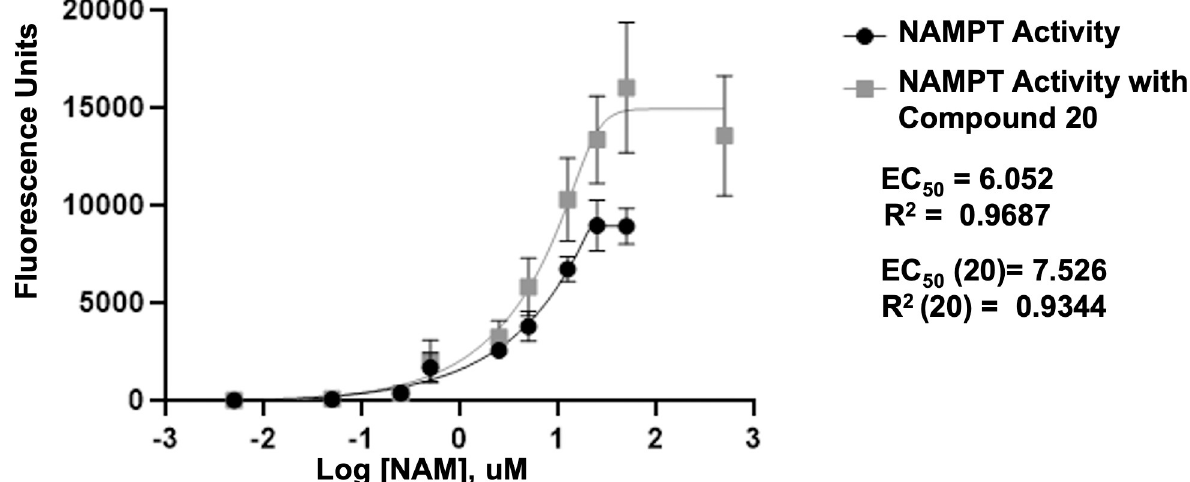
Fig 5. NAMPT activity as a function of substrate NAM concentration. Black circles represent NAMPT activity without compound 20 present while gray squares are with 20uM of compound 20 present. Each graph represents the average of three independent trials each containing three replicates per data point. Data was analyzed using the GraphPad prism software with a non-linear regression, asymmetric sigmoidal, 5PL equation and fitted with the least-squares method.